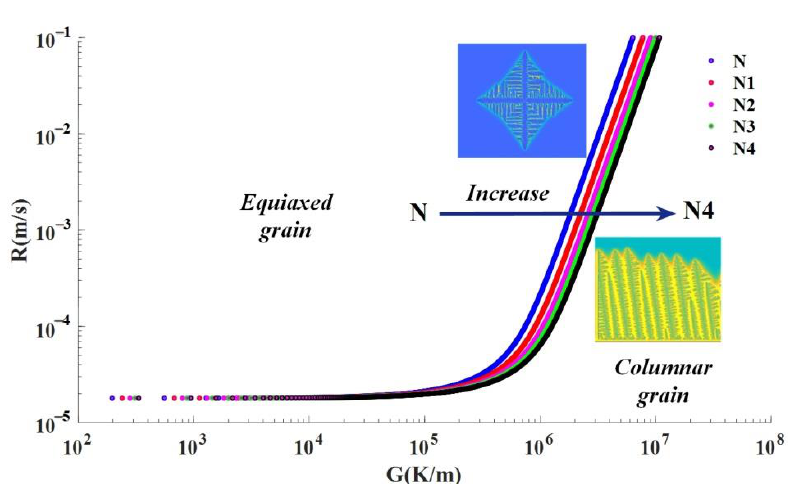
Figure 14. Curves of K value varying with nucleation N .